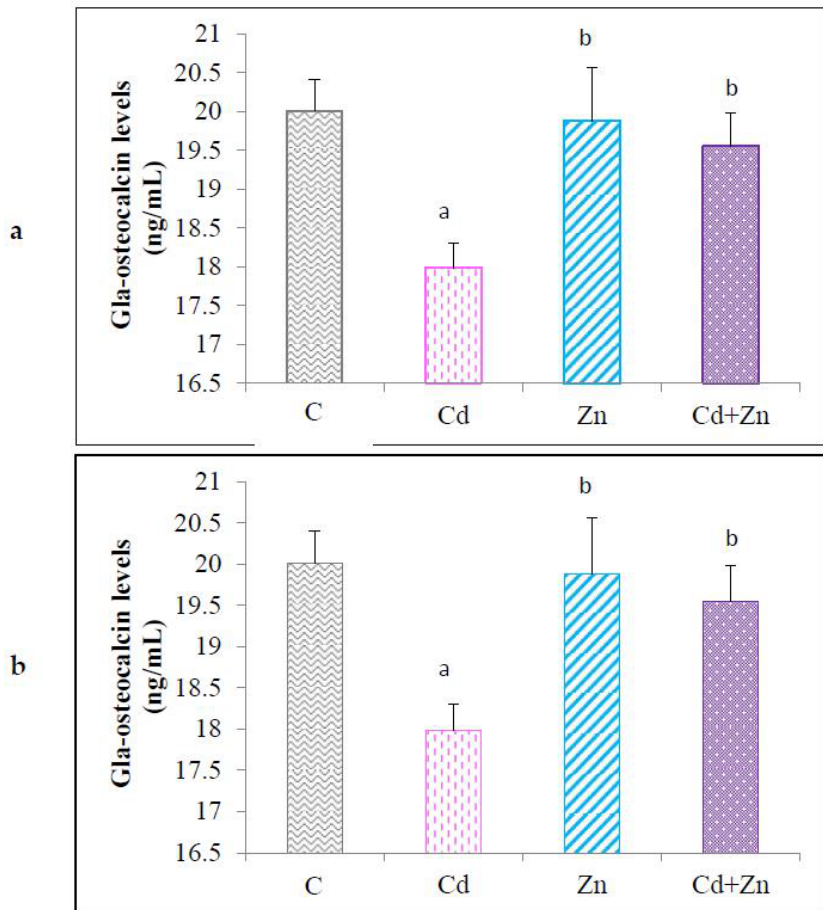
Figure 3. IGF-1 ( a ) and Osteocalcin ( b ) concentrations in the plasma of rat pups (PND21) from control females and pups from exposed to cadmium (50 mg / L Cd as CdCl2) and / or zinc (60 mg / L Zn as ZnCl2) during gestation and lactation. Means ± SEM from six samples in each groups; a* ( p < 0.01); a ( p < 0.05): significant di ff erence compared to the control group (C); b* ( p < 0.01); b ( p < 0.05): significant di ff erence compared to the Cd group (Cd); c ( p < 0.01): significant di ff erence compared to the Zn group (Zn).